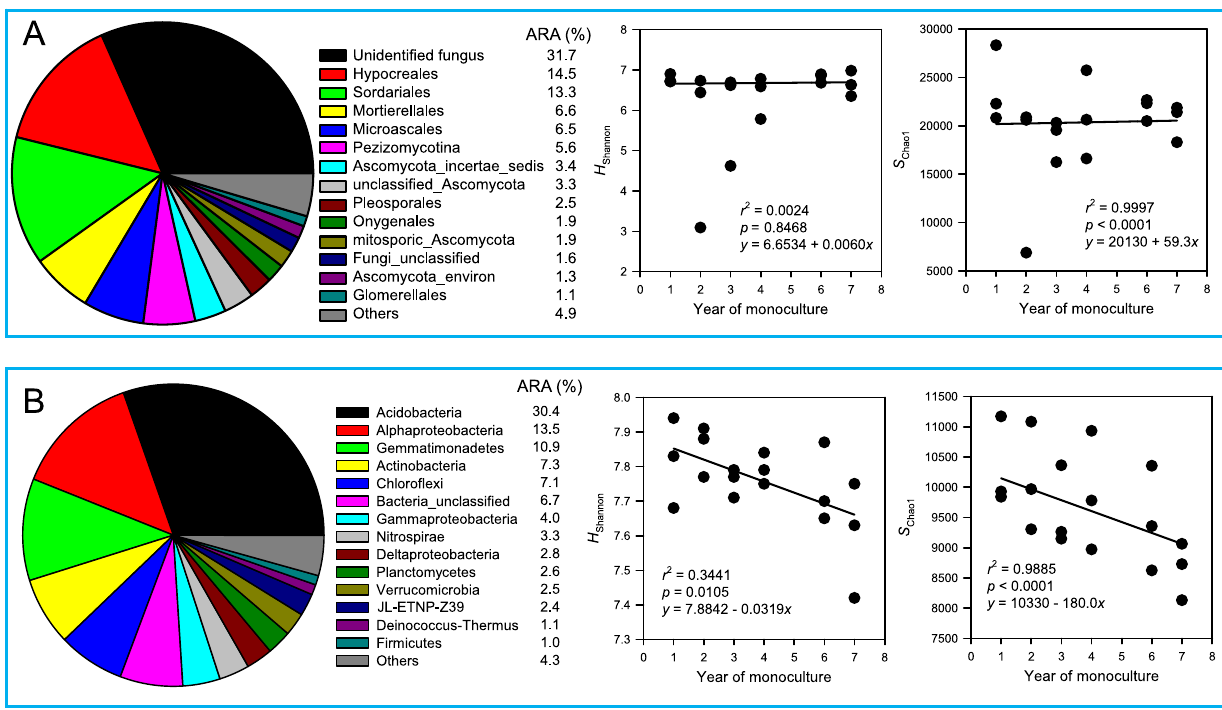
Figure 1. Overall fungal (A) and bacterial (B) communities in the soil samples along a year-gradient of potato monoculture. Pie charts show the average relative abundance over 18 samples. OTUs were assigned at the 97% identity level, based on which the H Shannon and S Chao1 indices were calculated, which are shown by graphs. Phylogenetic lineages of bacteria were assigned by phylum/subphylum and of fungi by order or higher levels. ARA stands for average relative abundance. The ‘‘unidentified fungus’’ is a taxon able to be assigned to kingdom Fungi but unable to any lower taxon.